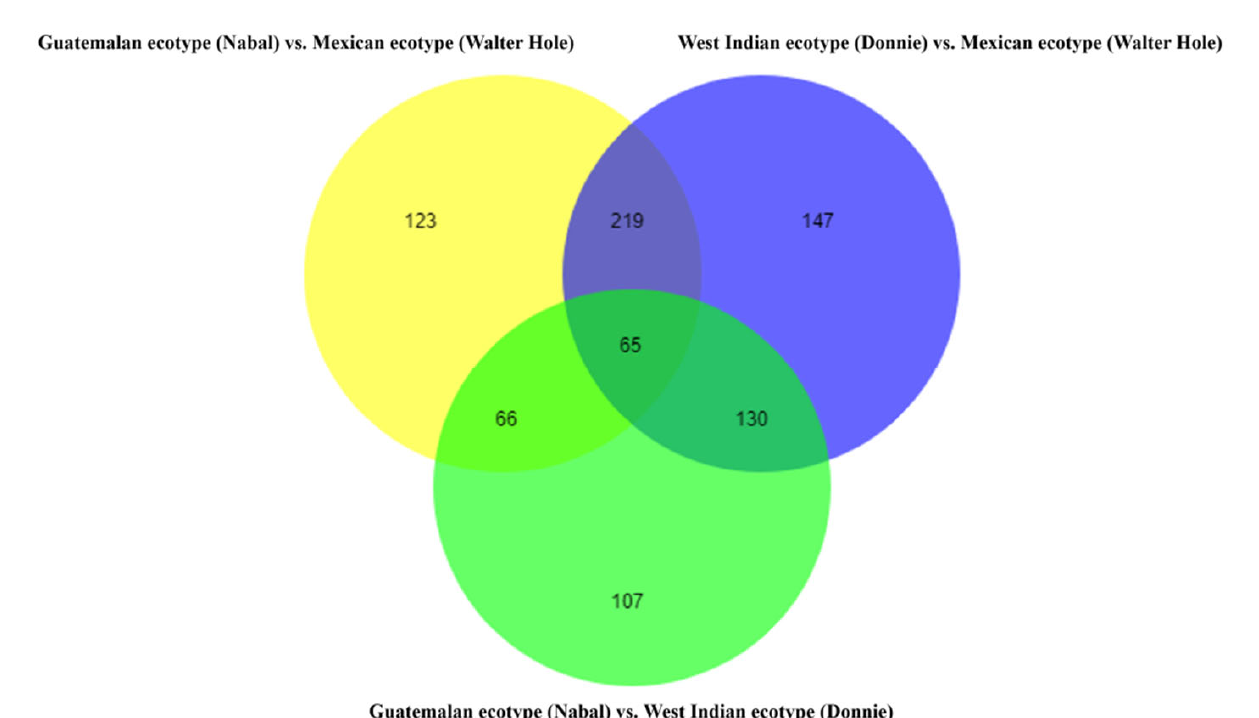
Error bars indicate standard deviation from three biological replicates of each ecotype. Means with the different letters indicate significant differences (Duncan, p ≤ 0.05) among mature avocado mesocarp of three ecotypes.